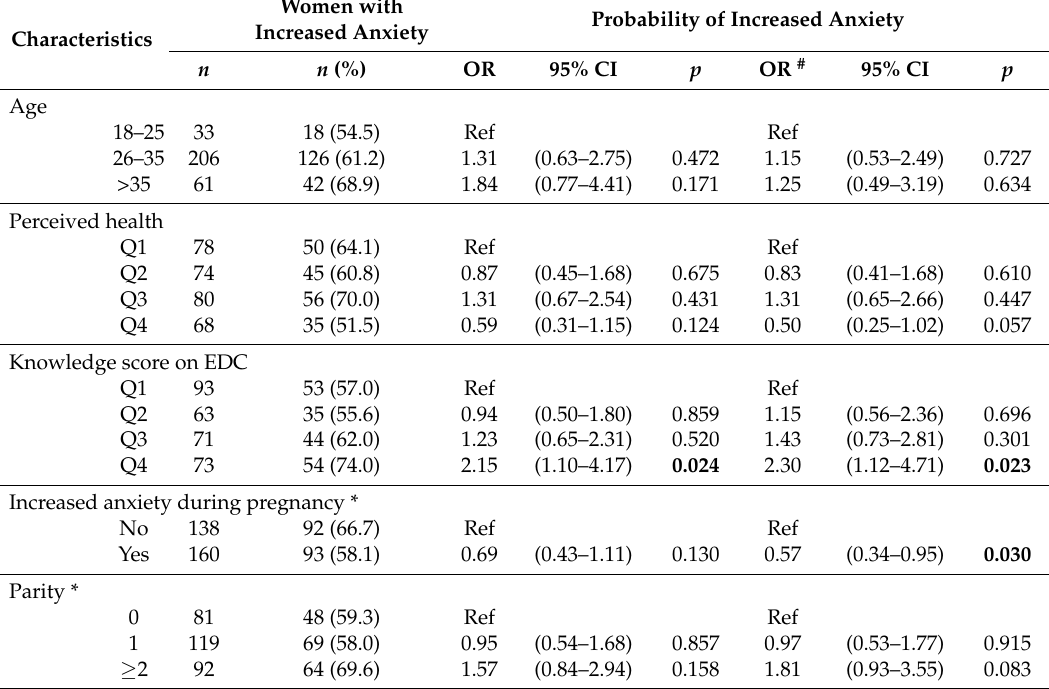
Table 4. Predictors of increased situational anxiety after